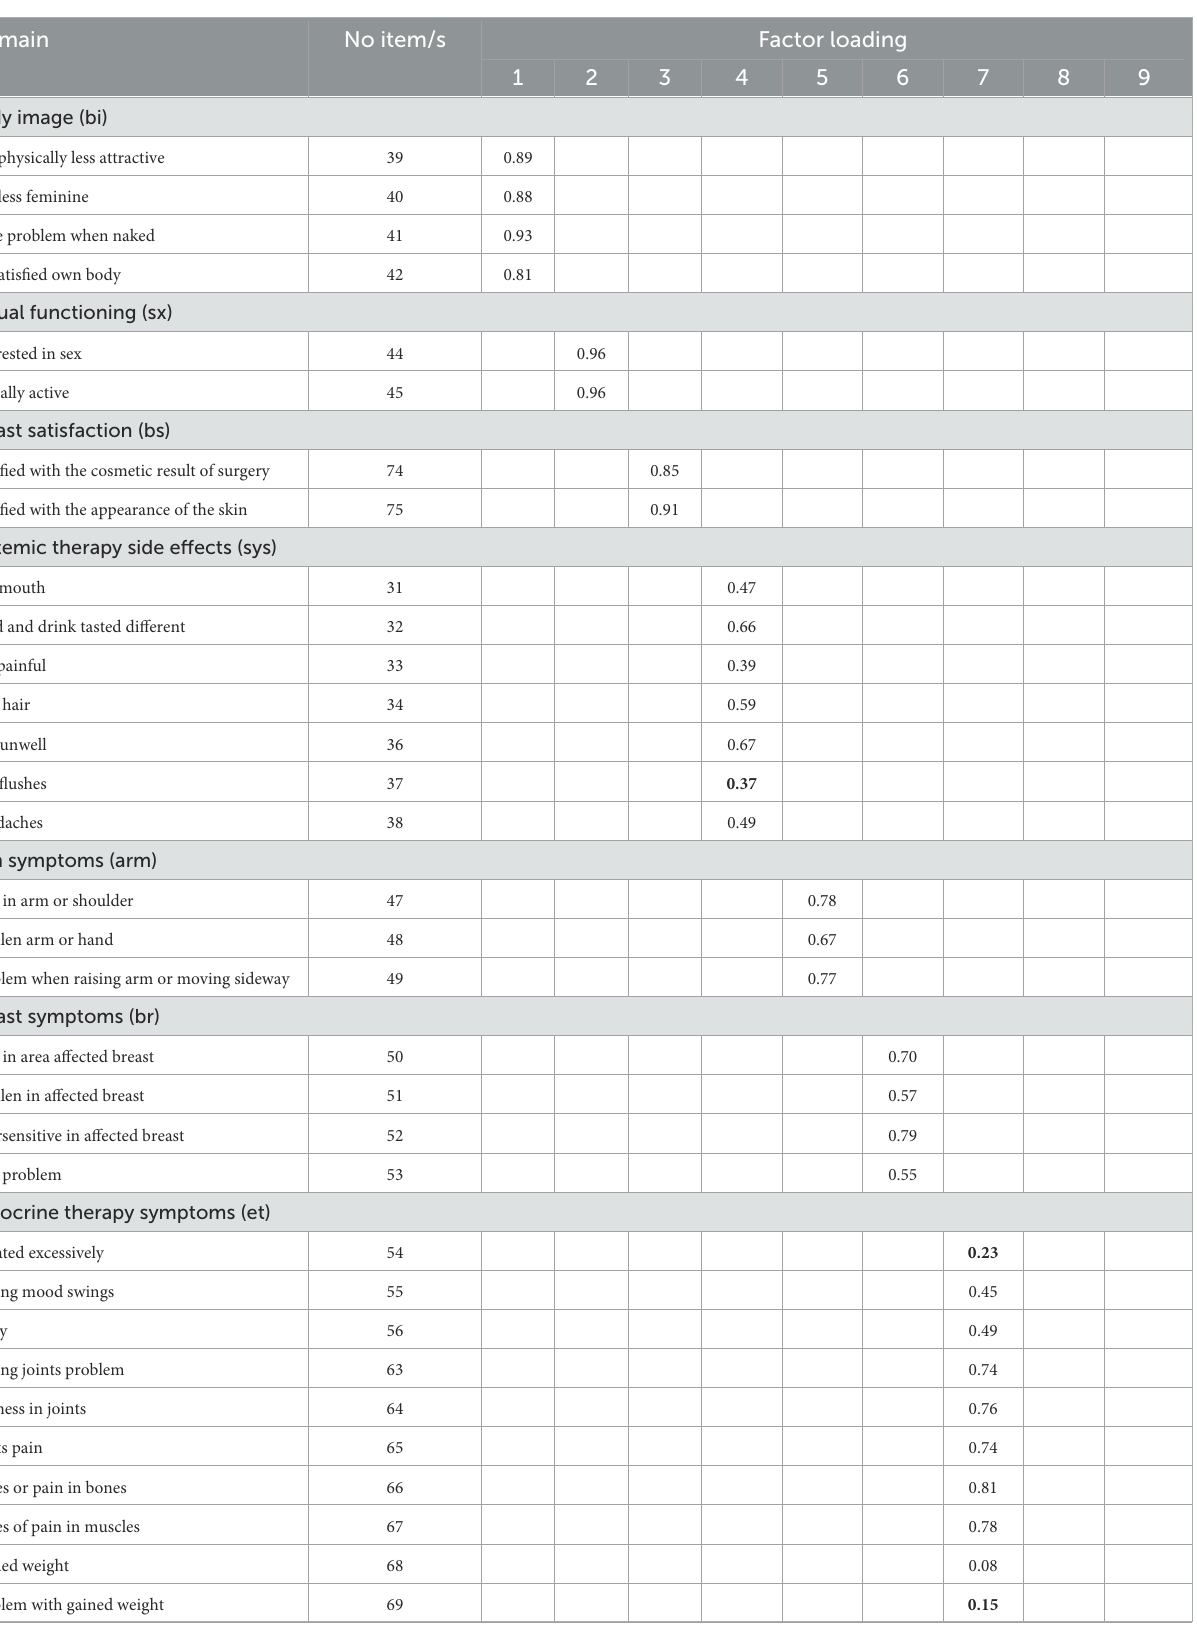
TABLE 2 Standardized factor loading of the Indonesian EORTC QLQ